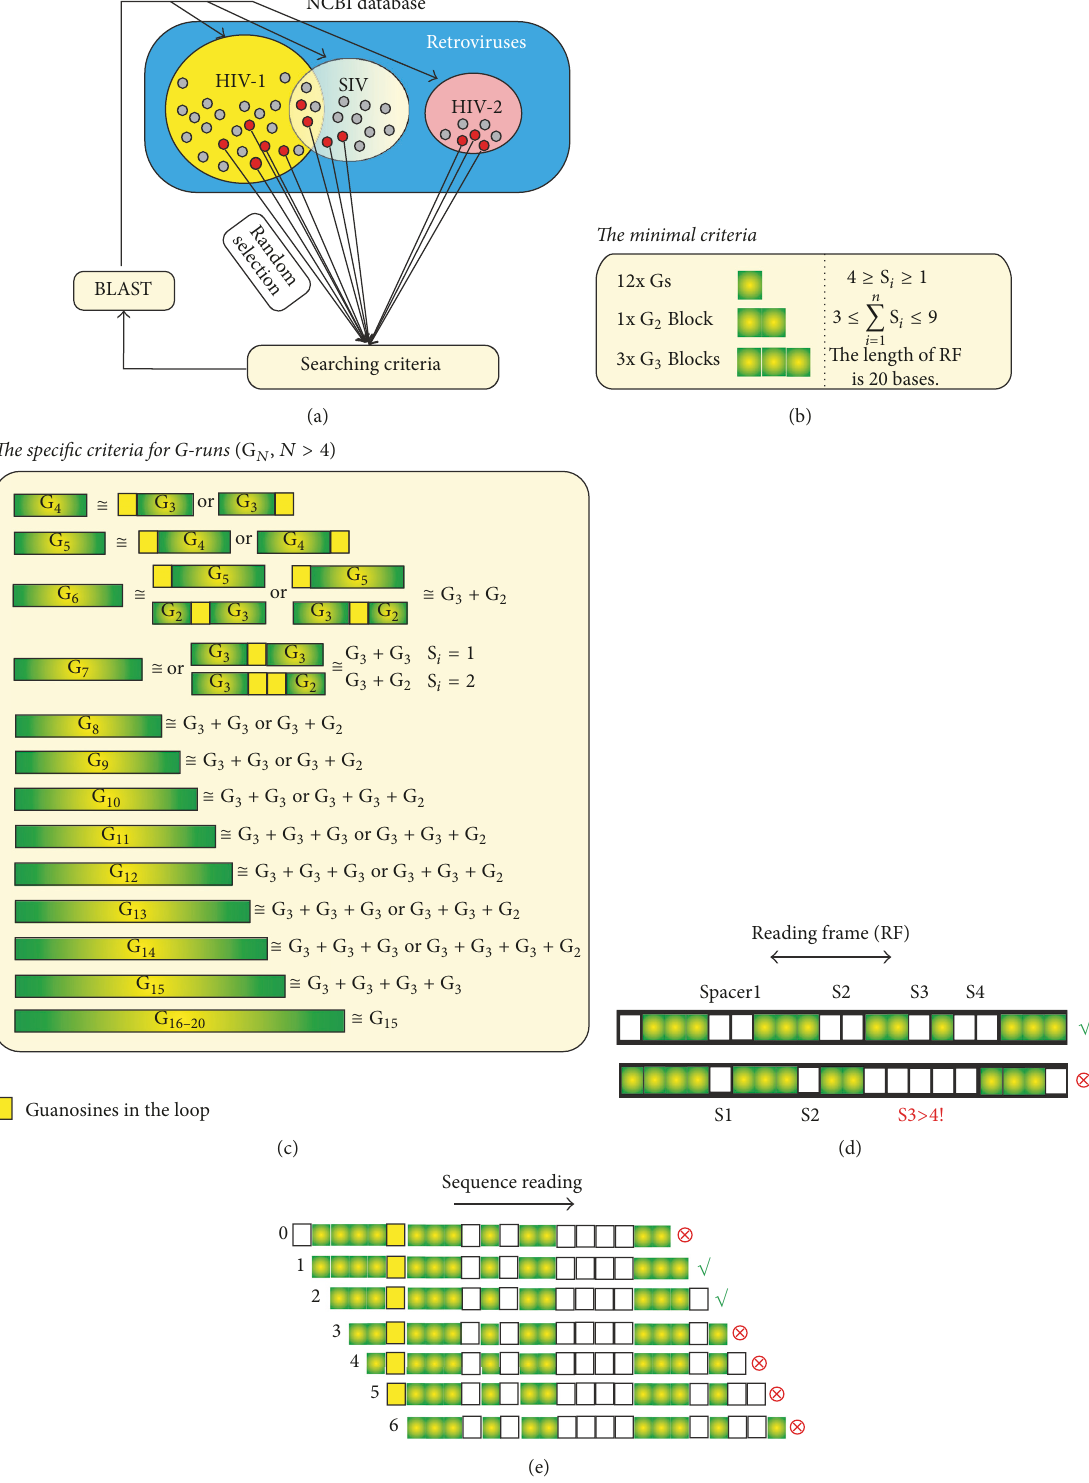
Figure 2: Strategy and searching criteria of putative G-quadruplex sequences. Randomly selected genomic sequences of HIV-1, HIV-2, and SIV from NCBI Gene database were analyzed (panel (a)). The criteria used to determine putative G-quadruplex sequences are listed in panel (b). ∑ 𝑆 𝑖 represents the total number of nucleotide residues between G-runs (G 3 and G 2 ), and this value is restricted at the interval ⟨3 – 9⟩ . Specific criteria were applied in cases in which G-runs consisted of more than four Gs (c); for instance, G islands interrupted with one G (yellow square) or one G3 and G2 connected with two “yellow” Gs. The occurrence of putative sequences was researched by BLAST in other viruses listed in the Gene database. Positive and negative examples of the search procedure are shown in panels (d) and